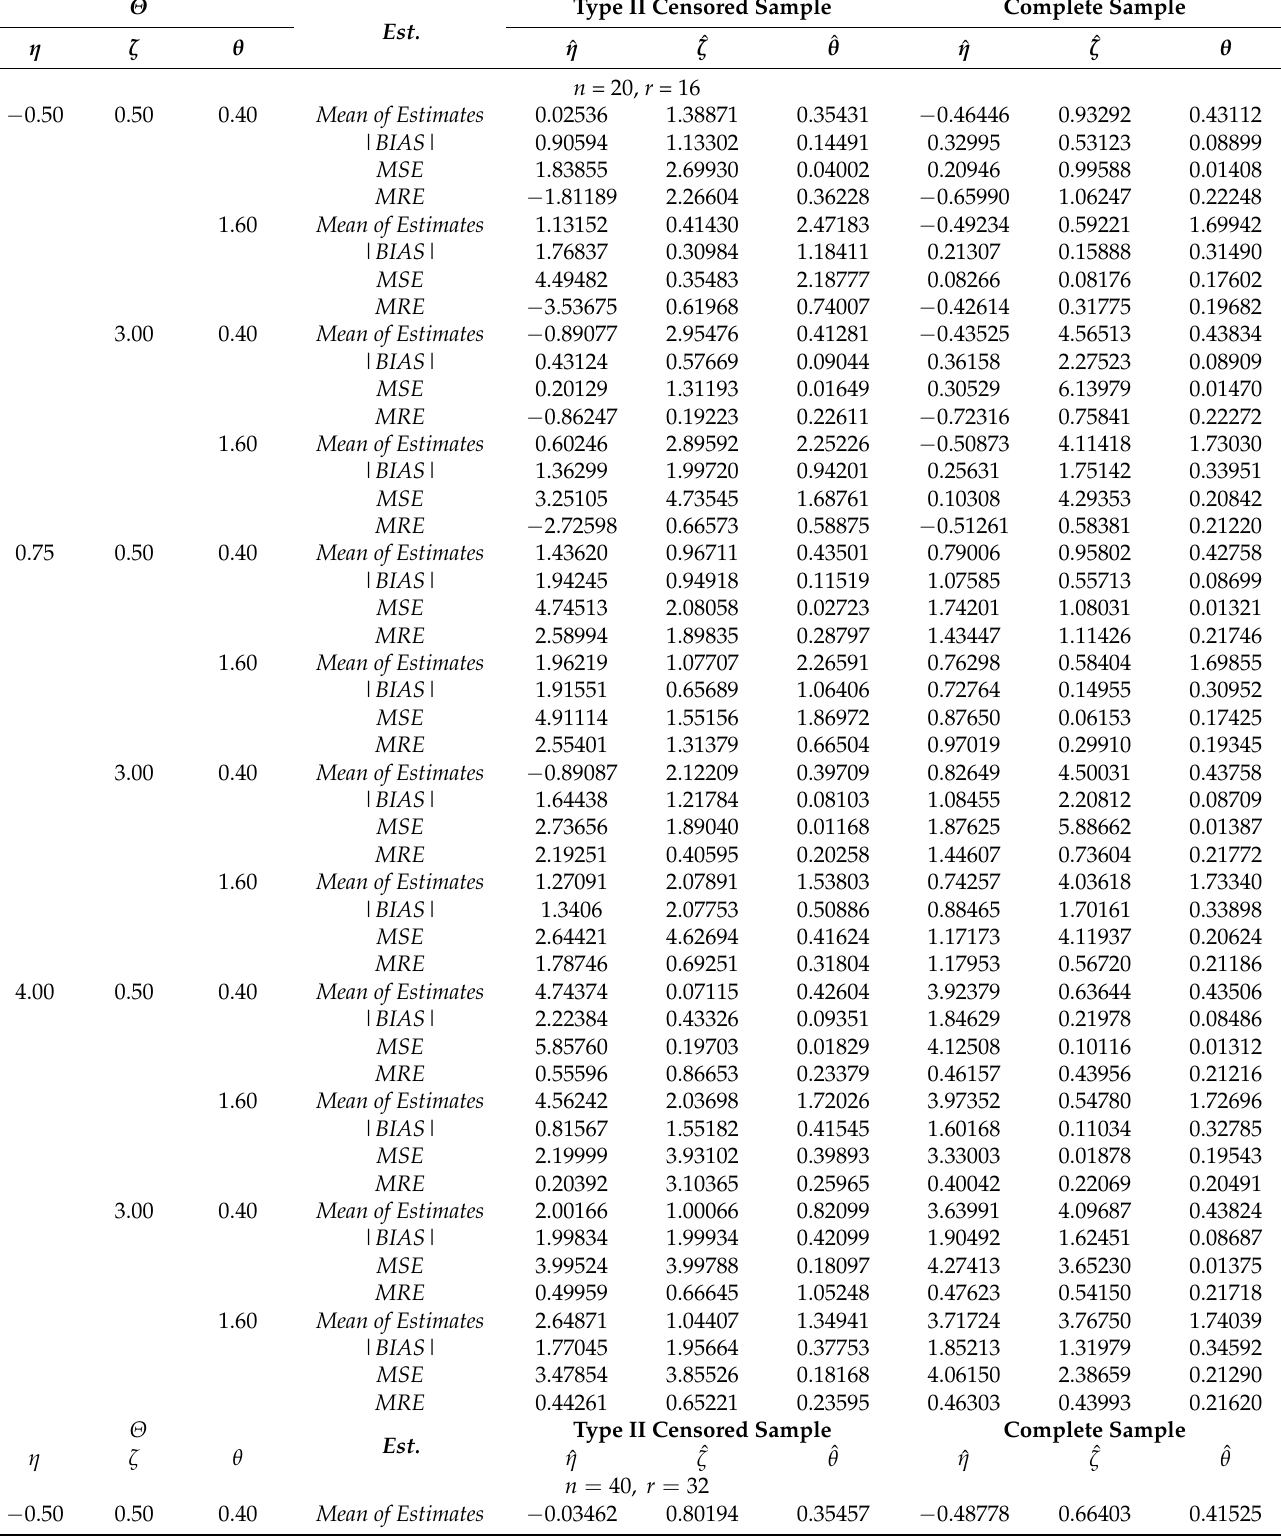
Table 7. Simulated results of the E-NPF distribution under complete and type II censored samples for various combinations of Θ